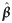
Soybean coefficients in the logit scale (β^ ±SD, 95% BCI) on logit occupancy (logit ψ^) of each bird species in the regional bird monitoring program in Argentina, 2003–2012.(a) Raptors; (b) ground omnivores and herbivores; (c) ground granivores; (d) other granivores; (e) insectivores mostly associated with folliage; (f) other insectivores. For details of species names and guilds, see S1 Table.